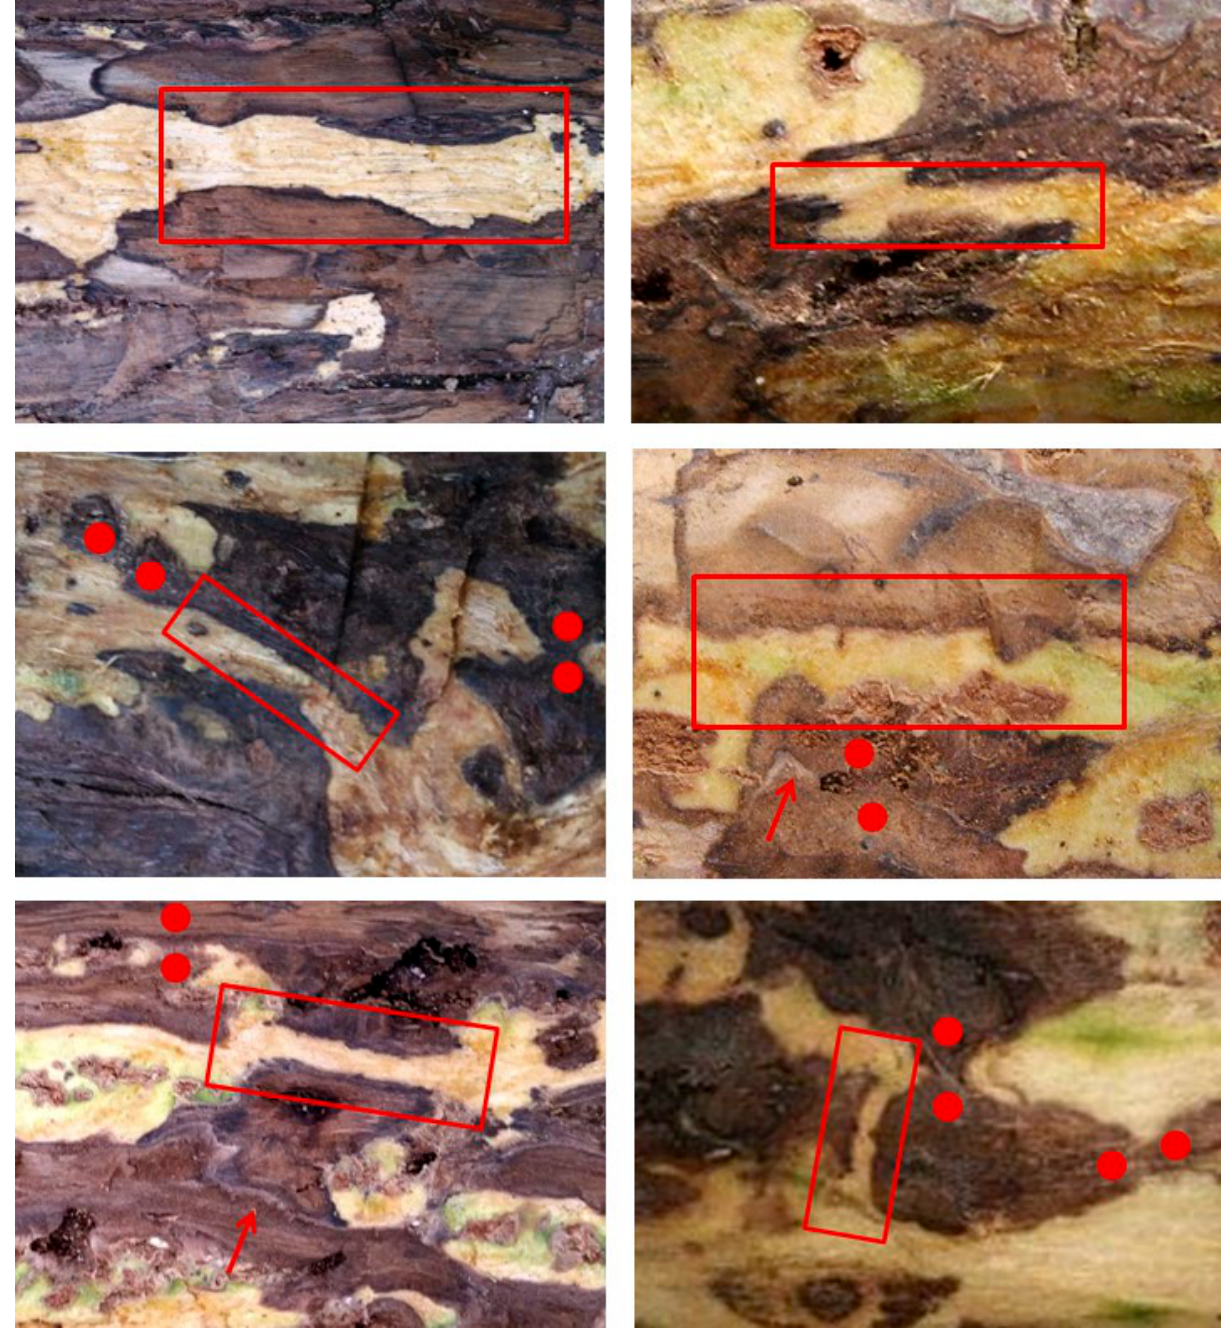
Figure 1. In addition to the typical diffuse and coalescing Geosmithia morbida cankers (facing dots), other cankers are sepa- rated by a constant sub-parallel line that is 2–3 mm wide and does not merge (rectangles) or by an inconstant thinner line (arrow) that partially merges. Left column: black walnut; right column: European